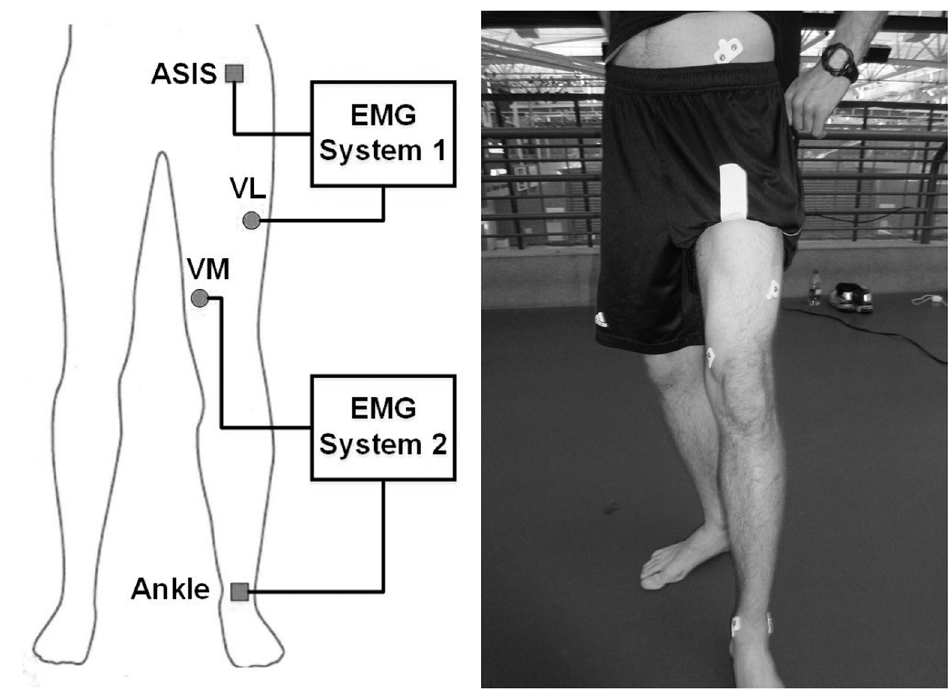
Fig 2. EMG recording